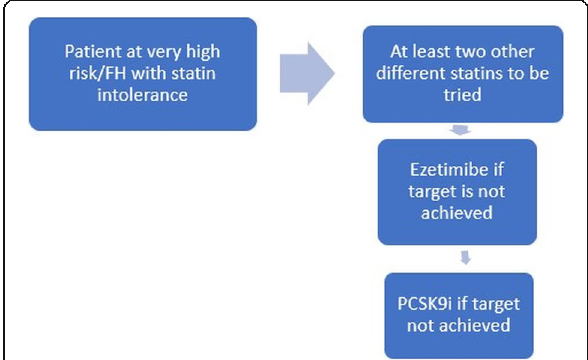
Fig. 2 Proposed algorithm for the starting of PCSK9 inhibitors in statin-intolerant